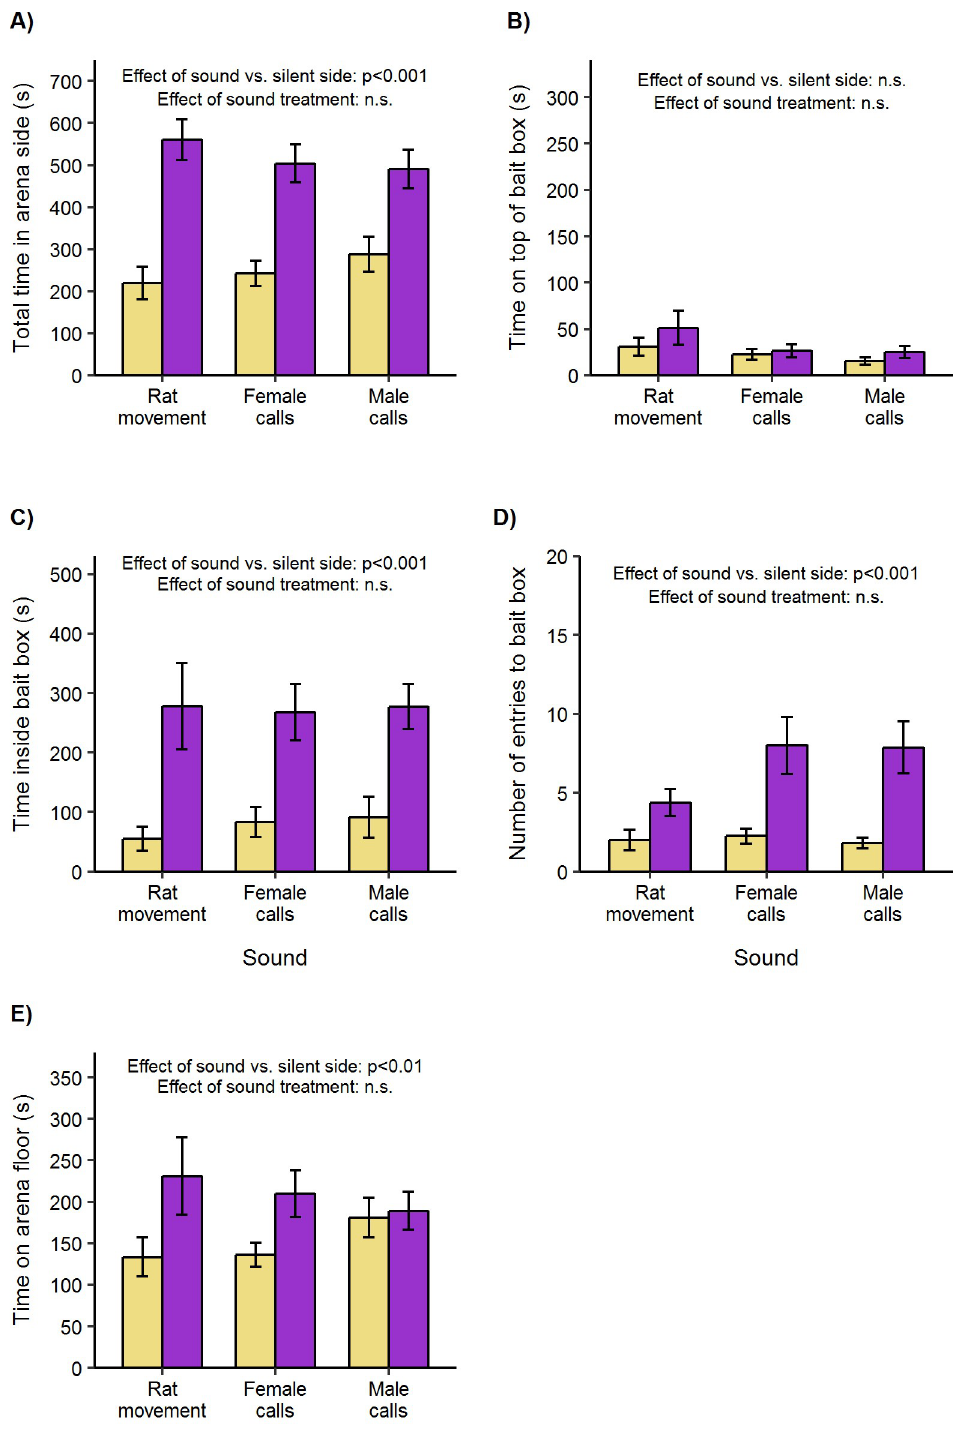
Fig 3. Attraction to rat sounds playing inside empty bait boxes (mean ± standard error of mean). Adult male and female Wistar rats were presented with sound playing through a box (purple bars) versus no sound (yellow bars, control) in opposite sides of a test arena. A) Total duration in each side compartment of arena. B) Duration on top of box. C) Duration inside box. D) Number of entries to box. E) Duration on arena floor (in arena side but not in or on box). Bias between sides was compared between treatments using repeated measures ANOVA followed by pairwise